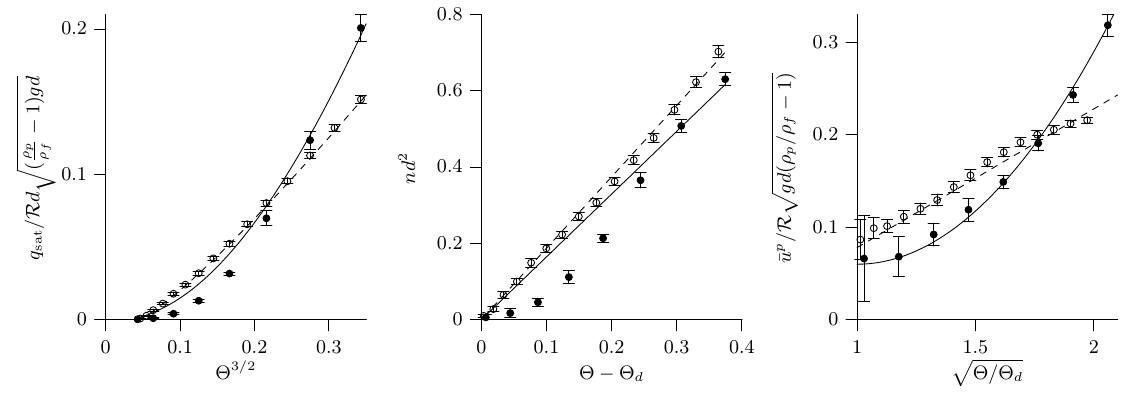
Fig. 5. Saturated flux (a) , moving grain density (b) and mean grain velocity (c) as functions of the Shields number for two values of the grain Reynolds number R (the density ratio is kept constant: ρ p /ρ f = 2). Filled symbols: data for R = 0 . 1. Empty symbols: reference data for R = 10, as in Figs. 2 and 4. Solid lines, see